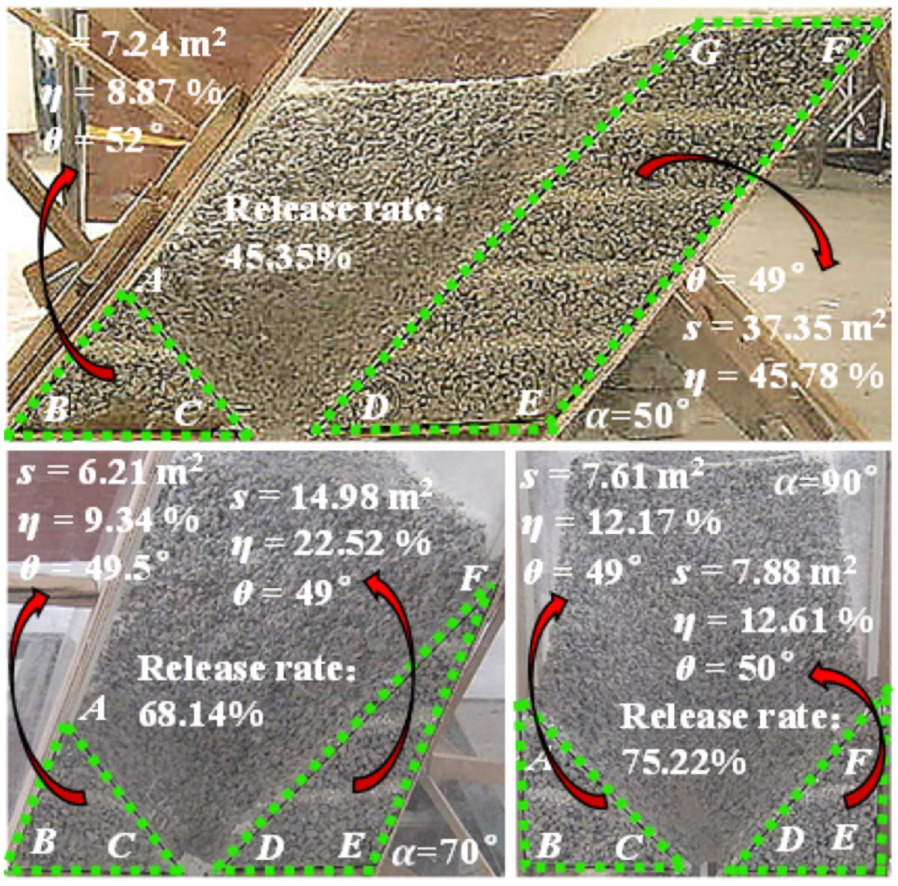
Fig 4. Resting forms at different